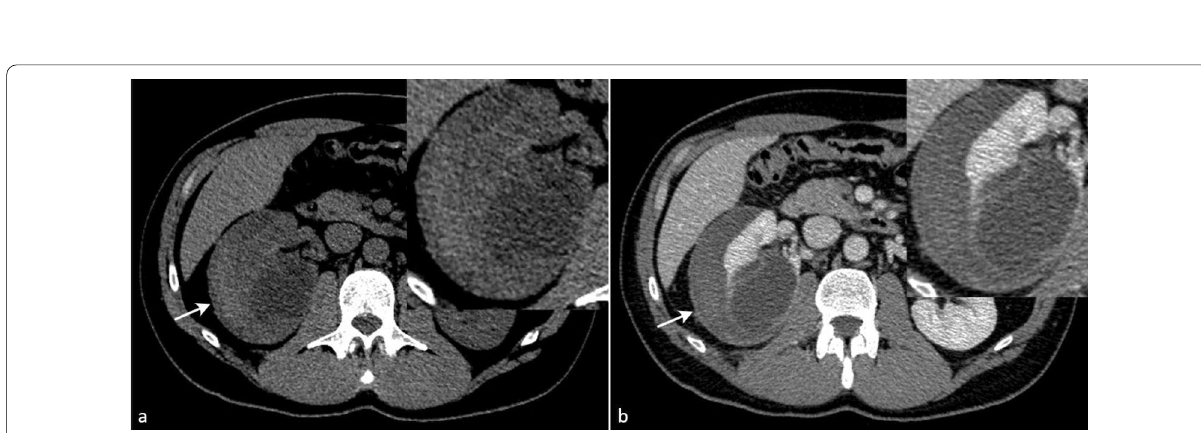
Fig. 2 CT showing a large hematoma (arrow) surrounded by Gerota’s fascia in the perirenal space. a Pre-contrast sequences showing the cystic mass surrounded by a hyperdense haematoma in the perirenal space. b Portal venous phase in CT showing Gerota’s fascia enclosing the